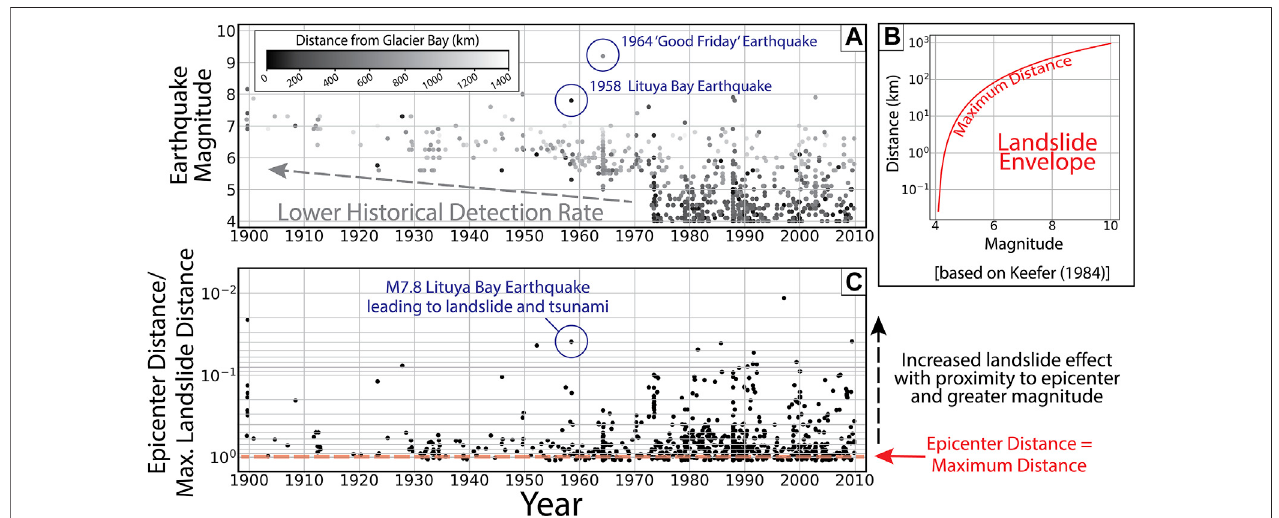
FIGURE2| Earthquakehistoryinregionalcircularwindow(1,400 kmmaximumdistance)surroundingGlacierBay.Periodofrecordstartedin1899andiscompiled herethrough2009(fromhttps://earthquake.usgs.gov/earthquakes/search/).Detectionrateofearthquakesbelowmagnitude(M)5islimitedbefore1973. (A) Plotofyear vs. earthquake magnitude with shading as a function of distance from Glacier Bay. (B) Plot of estimated maximum landslide-inducing earthquake distance as a function of earthquake magnitude, adapted from Keefer (1984). These subaerial landslide-derived data serve as aconservative estimate for submarine landslides that have been shown to occur at greater distances from earthquake epicenter (e.g., Fan et al., 2020). (C) Log-normal plot of earthquakes from Plot A expressed as a fraction of maximum landslide-inducing distance for that magnitude, i.e., the outer envelope of Plot B.